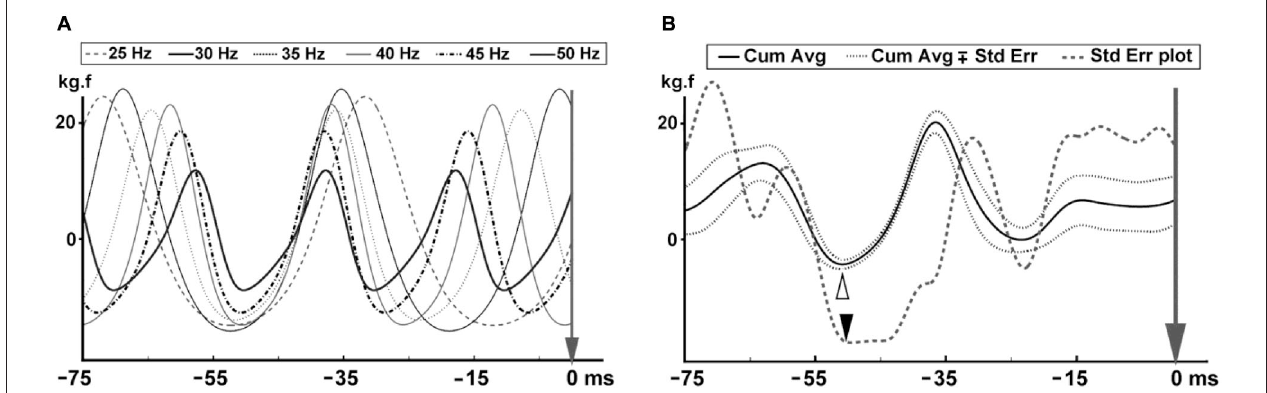
trace) for the cumulated average force trace. Thick continuous line shows the mean of the cumulated average force with its minimum value indicated using the white arrowhead. Thick dashed line is the SE for the cumulated average force trace with its minimum value indicated using the black